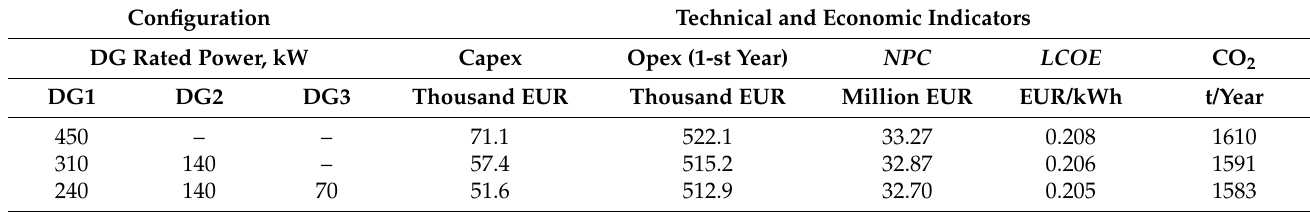
Table 6. Selection of the HES basic configuration.